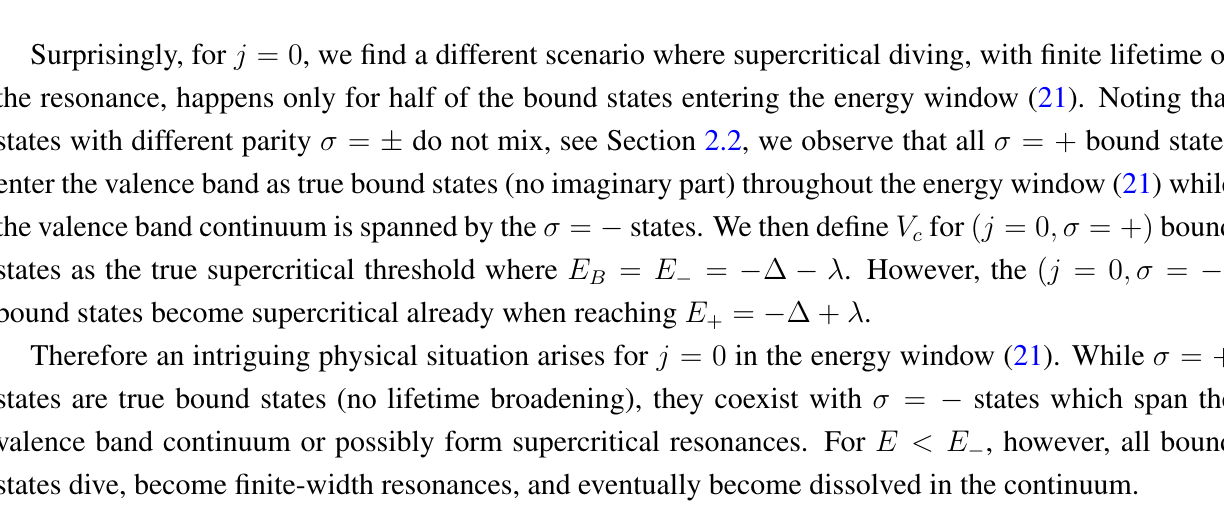
= V 0 t = V > V , where the 0 c t